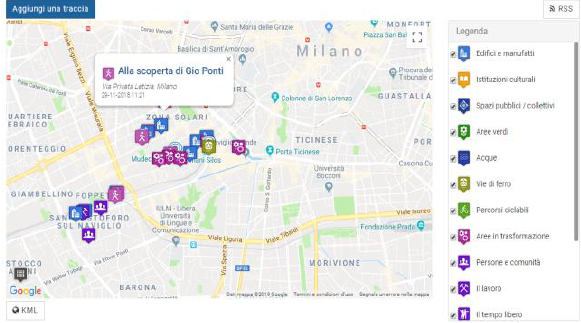
Figure 1. MUMI ecomuseum map (source: https://www.mumi- ecomuseo.it/infodiscs/index/4 , ©MUMI Ecomuseo Milano Sud)